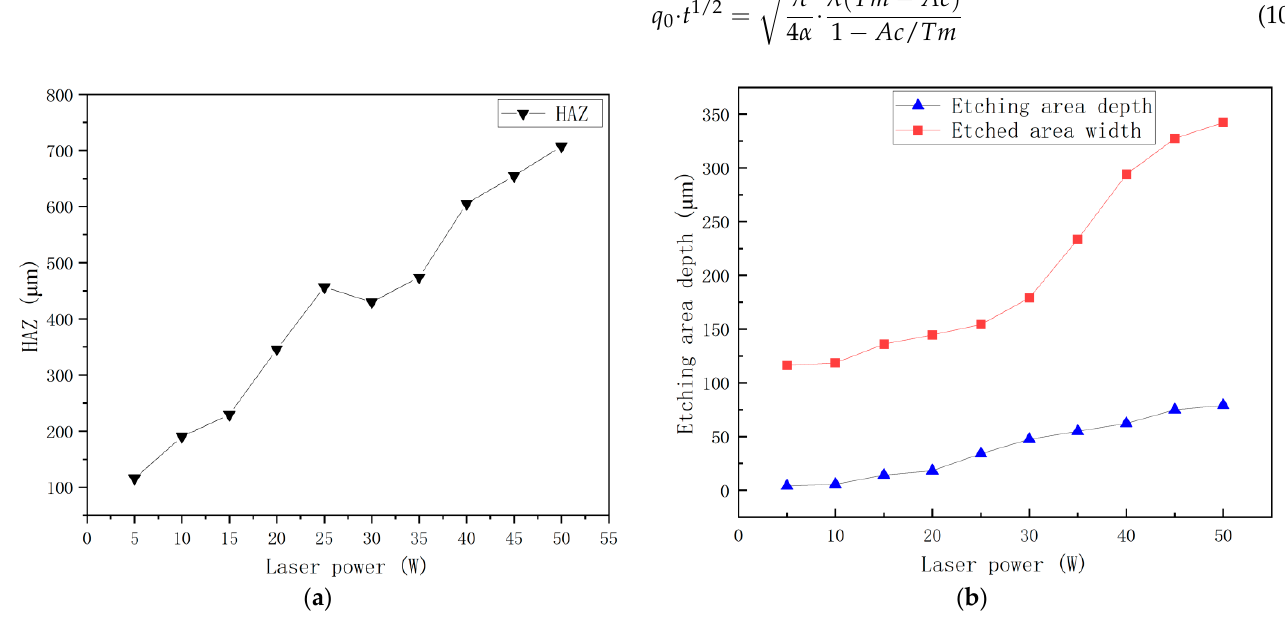
Figure 6. ( a ) Heat-affected zone trend graph; ( b ) comparison of etching width and depth variation.